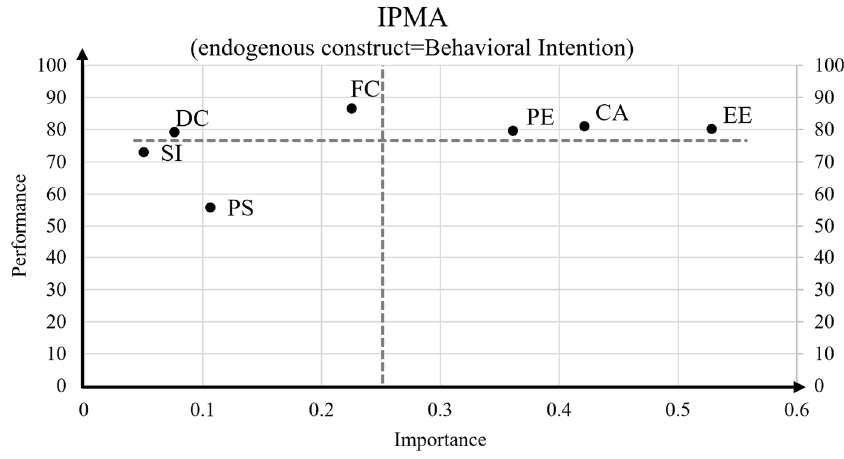
Figure 2. Estimated importance-performance map for the endogenous construct BI.